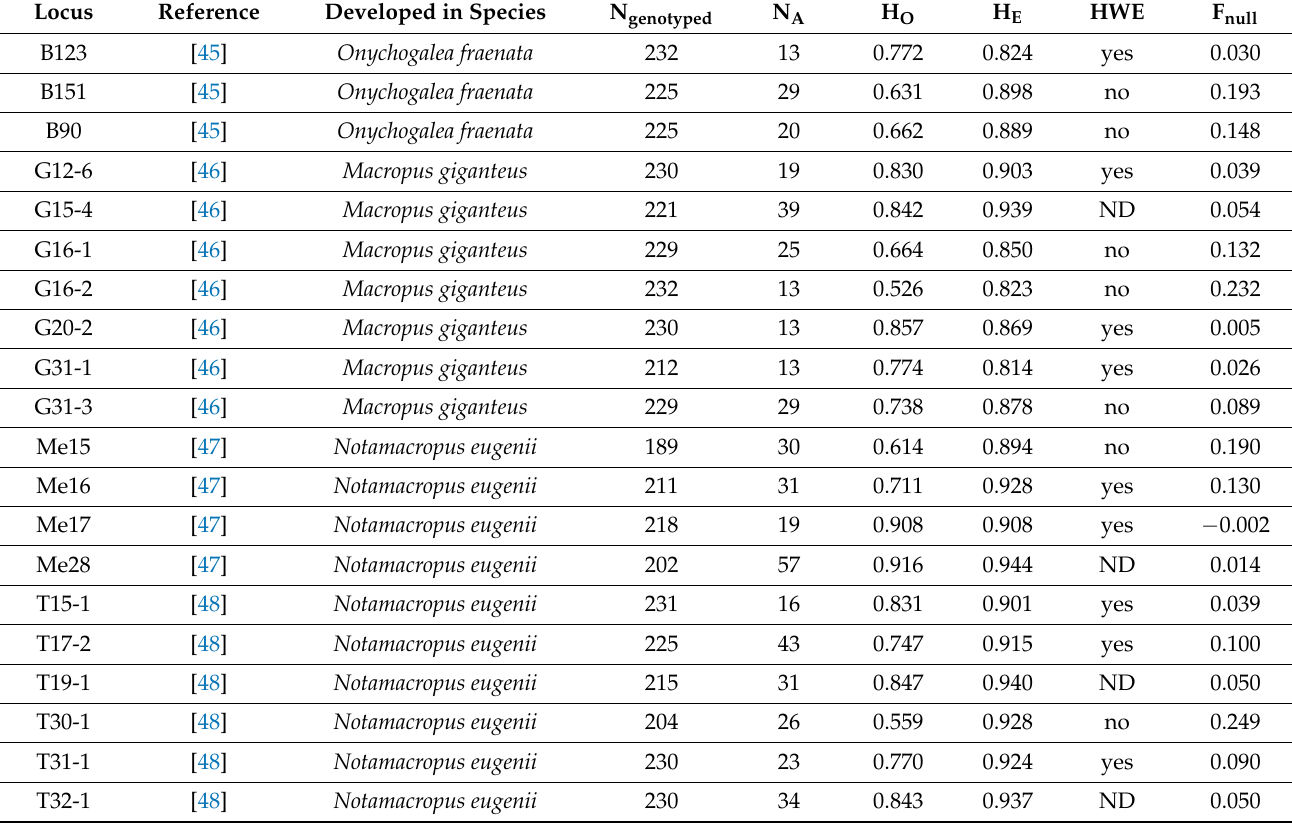
We estimated the current genetic effective population size (N e ) using the linkage disequilibrium (LDN E ) method [43], implemented in N E E STIMATOR 2.1 [44], excluding singleton alleles (i.e., alleles that occur in one copy in one heterozygote, which can upward bias N e estimation). N E E STIMATOR estimates genetic effective population sizes (N e ) from genotype data and the recently improved method implemented in the new version reduces bias in estimating N e and increases reliability of confidence intervals. Table 2. Indices of the 20 microsatellite markers used in this study, genotyped across 232 samples (see Table 1 for more details).